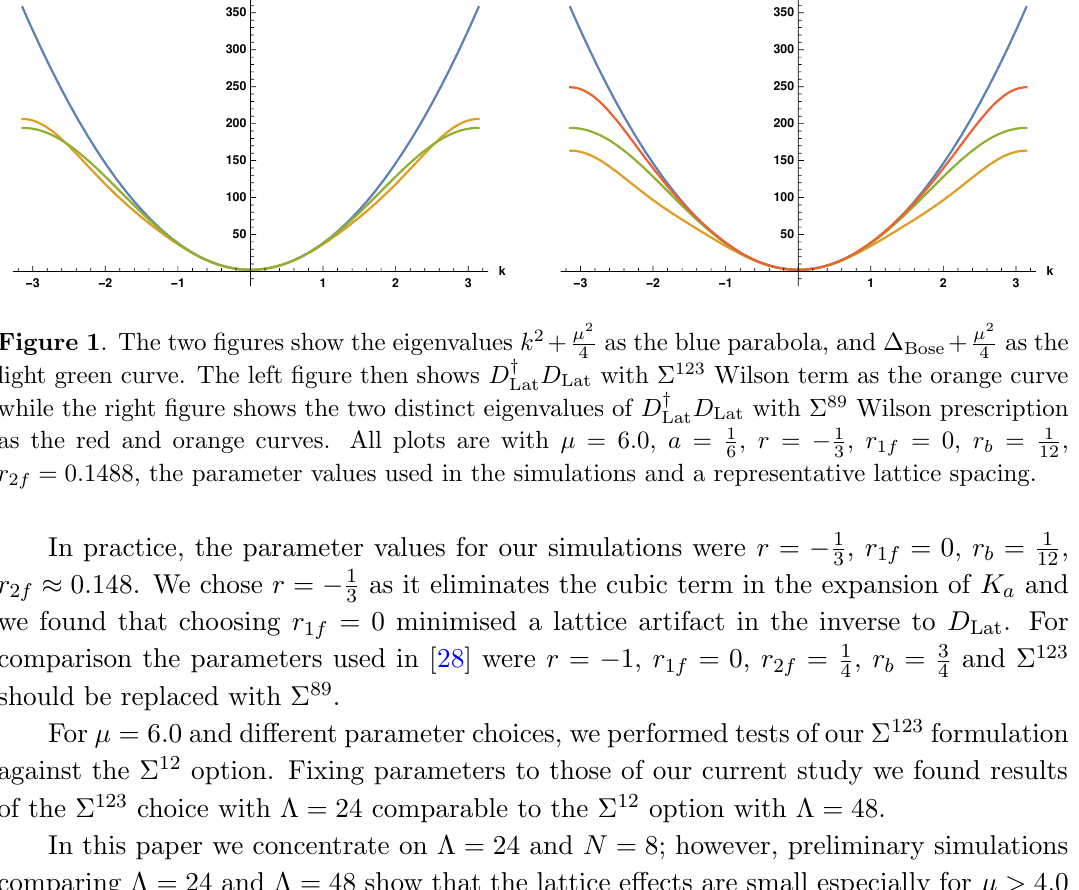
as the blue parabola, and (cid:1) Bose + (cid:22) 2 as the 4 4 D Lat with (cid:6) 123 Wilson term as the orange curve Lat D Lat with (cid:6) 89 Wilson prescription Lat , r = (cid:0) 1 , r 1 f = 0, r b = 1 , 6 3 12